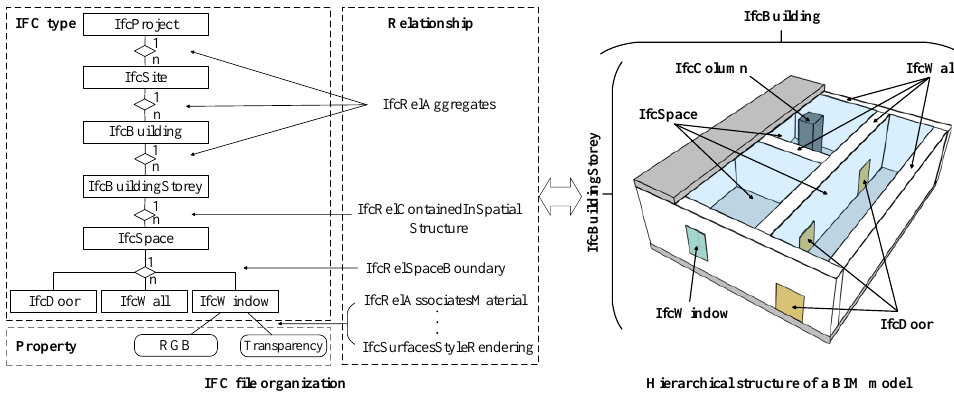
Figure 1. Building information modeling (BIM)/Industry Foundation Classes (IFC) data organiza- tion.